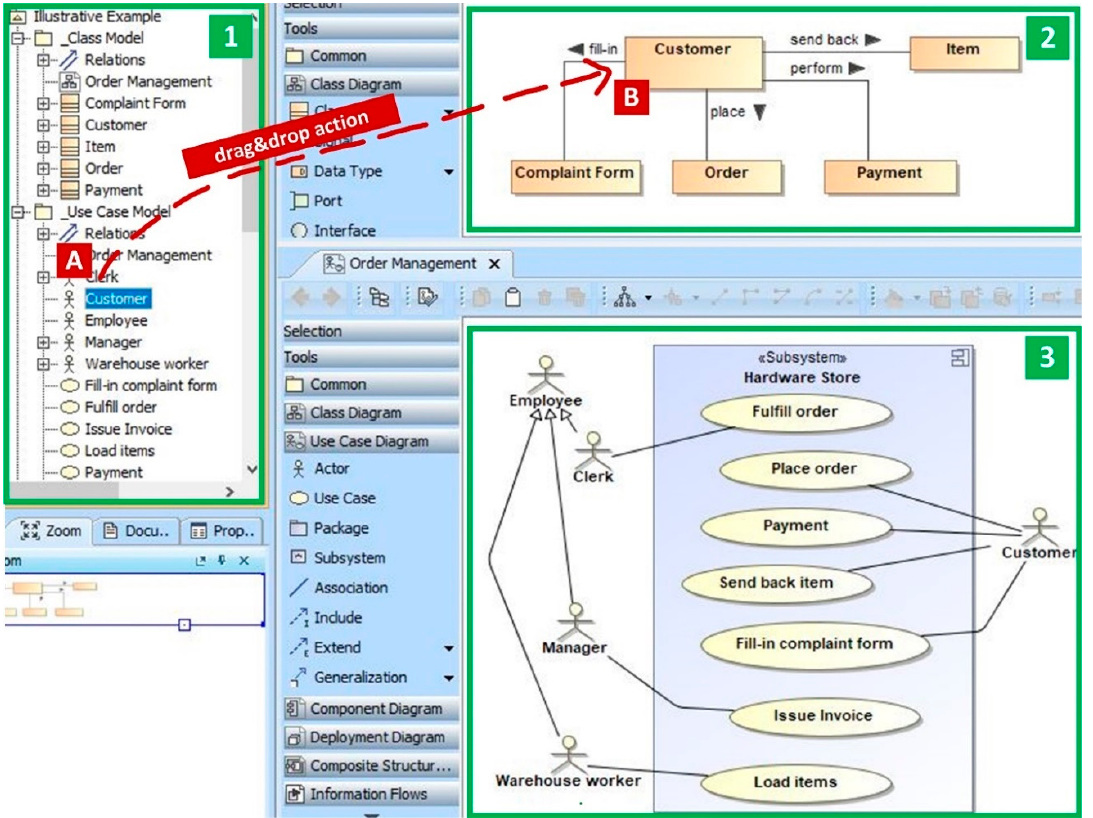
Figure 1. Illustrative example of partial model-to-model (M2M) transformation using drag-and-drop Illustrative example of partial model-to-model (M2M) transformation using action. drag-and-drop